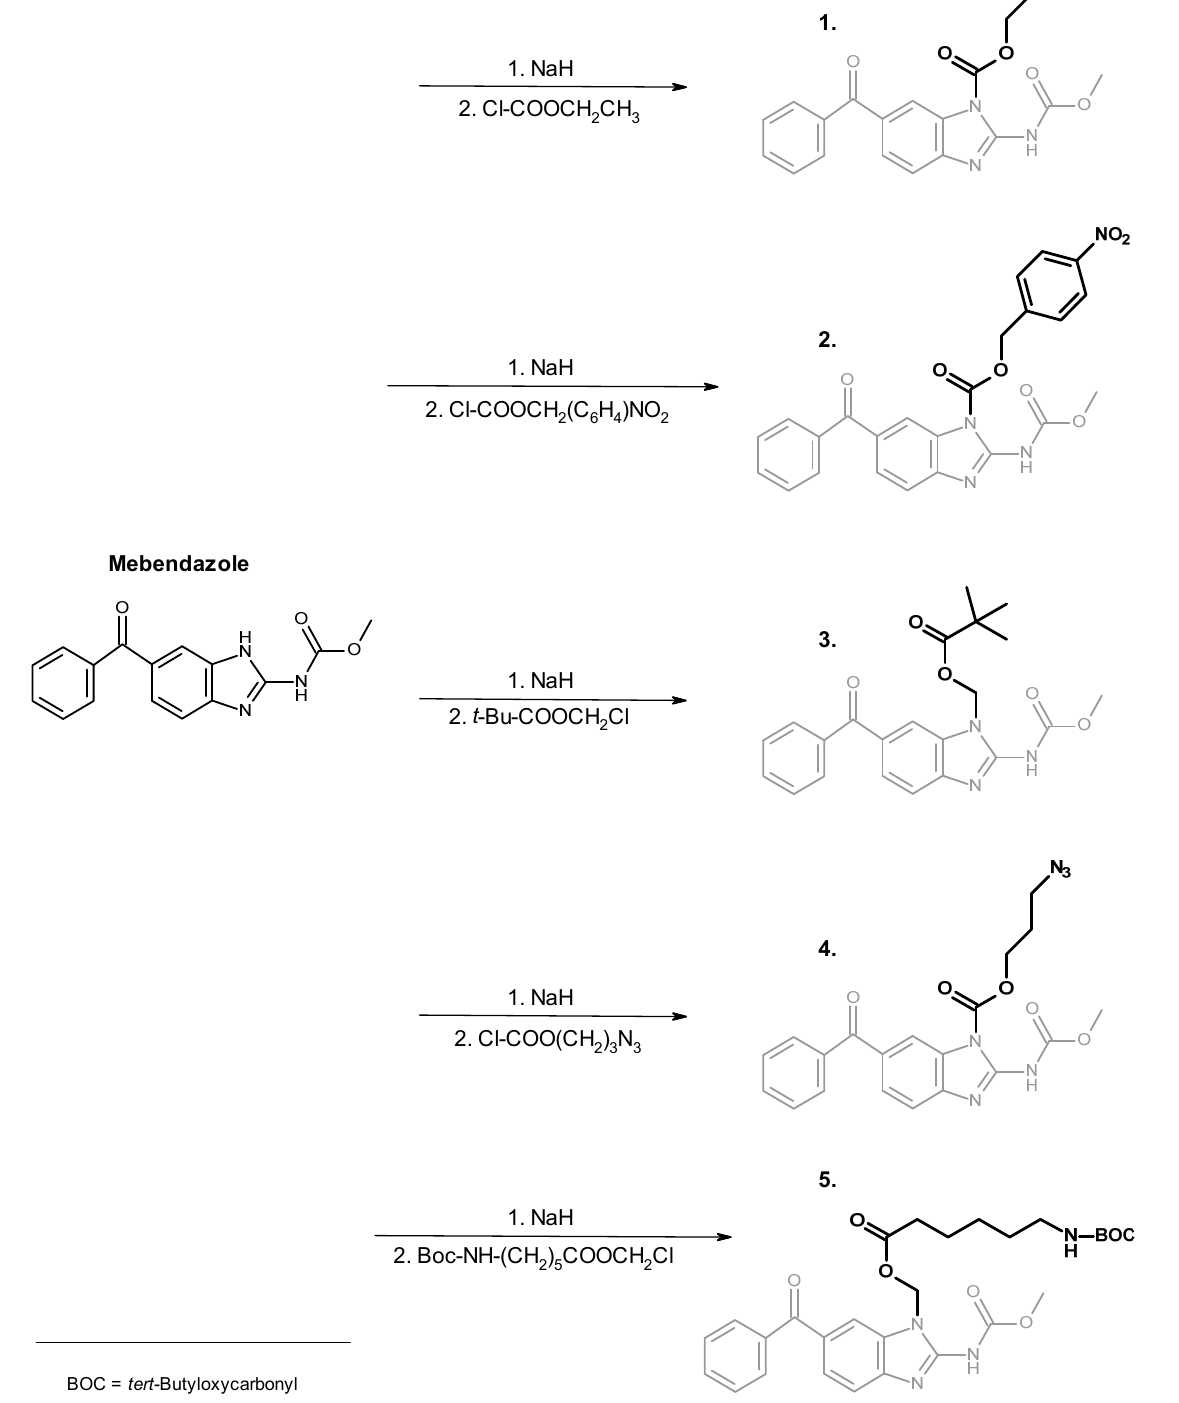
Figure 3. Synthesis of model mebendazole derivatives 1 – 3 and reactive derivatives 4 , 5 designed for the attachment to a polymer carrier.